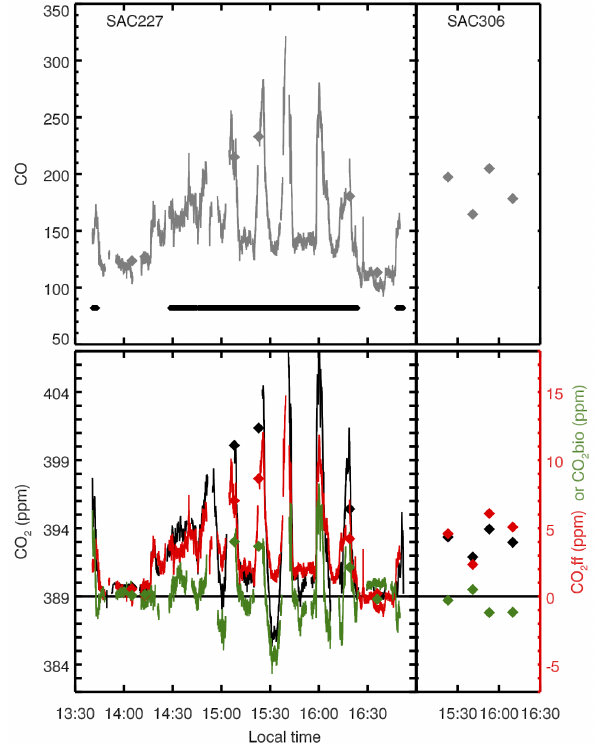
Fig. 7. Top panel: flask (diamonds) and in situ (lines) measurements of CO from SAC227 and SAC306. The black line indicates times when the aircraft was within the boundary layer. Bottom panel: flask (diamonds) and in situ (lines) measurements of: total CO 2 (black, left axis); CO 2 ff CO calculated from R CO / CO and contin- 2 ff uous CO (red, right axis); and CO 2 bio calculated as the residual of total CO 2 and CO 2 ff CO (green). Uncertainties are 1ppb in CO, 0.1ppm in CO 2 , 1ppm in CO 2 ff and CO 2 bio from flasks, and 0.2– 2ppm in CO 2 ff CO and CO 2 bio from in situ